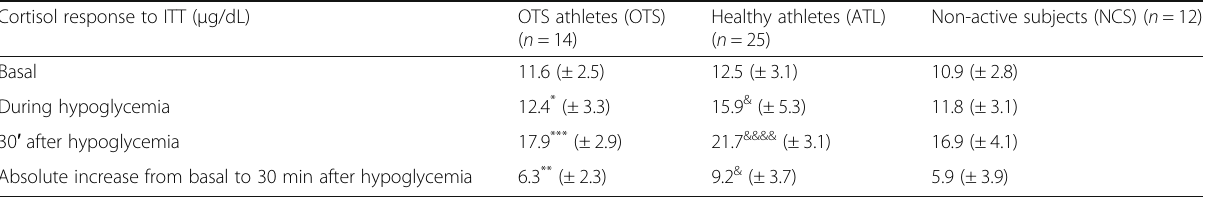
Table 2 Mean (±SD) basal serum cortisol and response to insulin tolerance test (ITT) Cortisol response to ITT ( μ